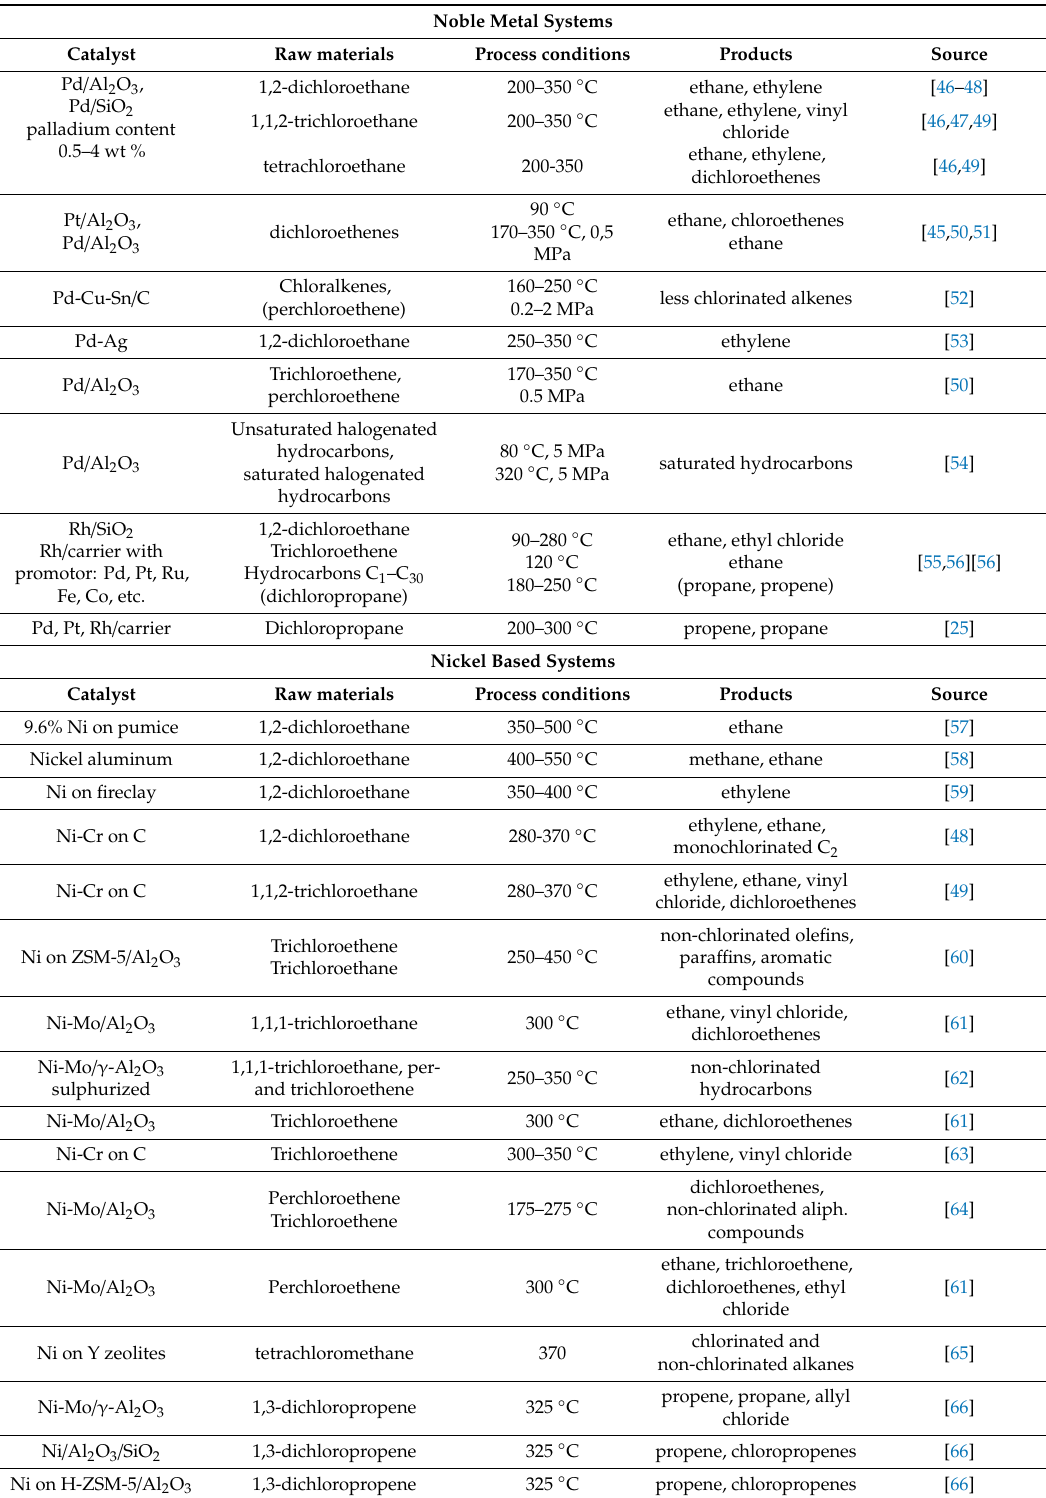
Table 4. Conditions of the hydrodechlorination process of chlorohydrocarbons in the presence of various catalysts based on the noble